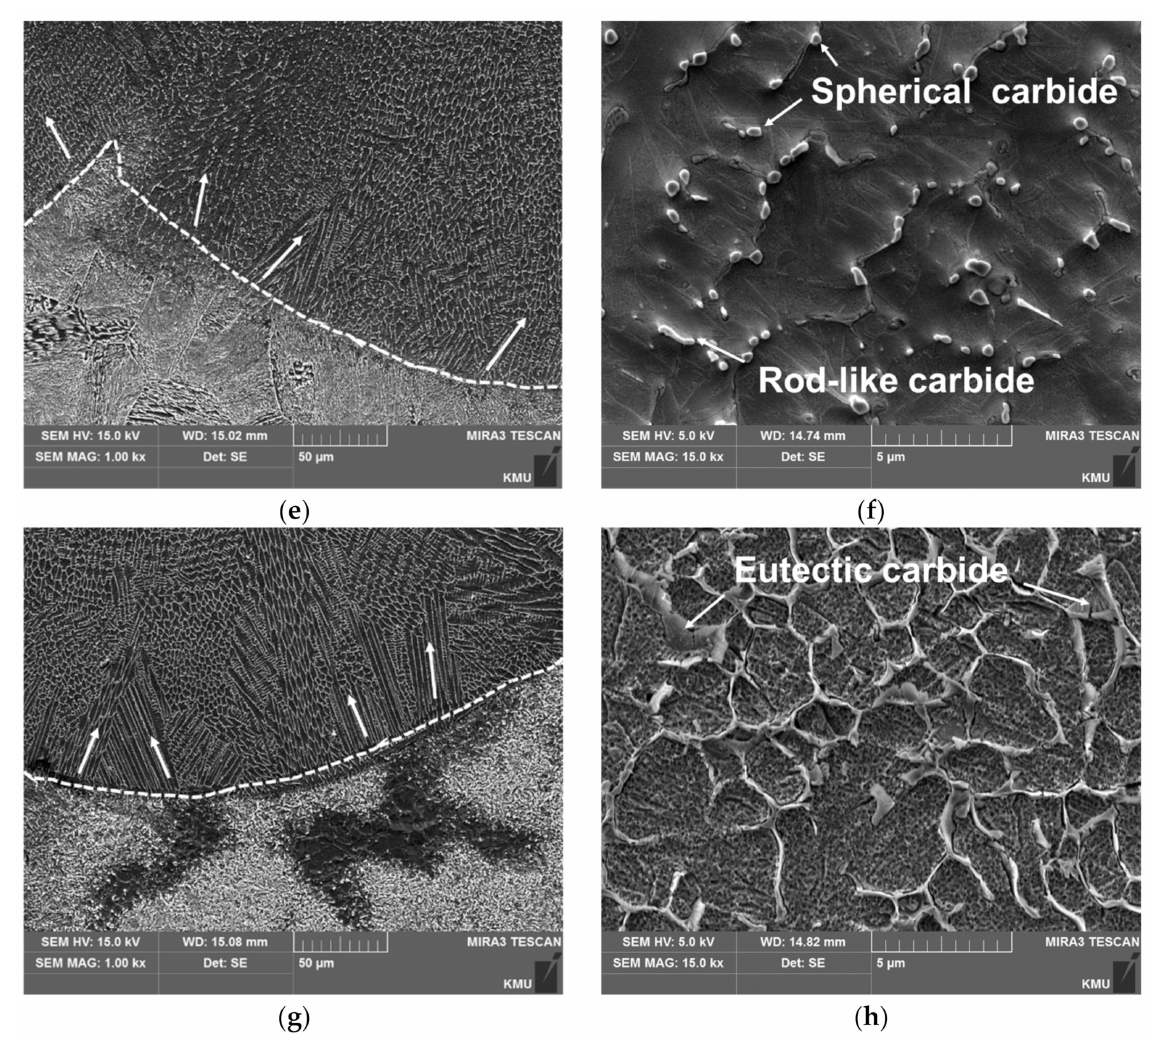
Figure 6. SEM micrographs of the microstructures: ( a ) C-SCM420, ( b ) carburized zone, ( c ) interface be-tween M2 deposits and substrate, ( d ) M2 deposited region, ( e ) interface between FeCrVMoW deposits and substrate, ( f ) FeCrVMoW deposited region, ( g ) interface region of as-built (FeCrVMoW)-PHT and ( h ) deposited layer of as-built